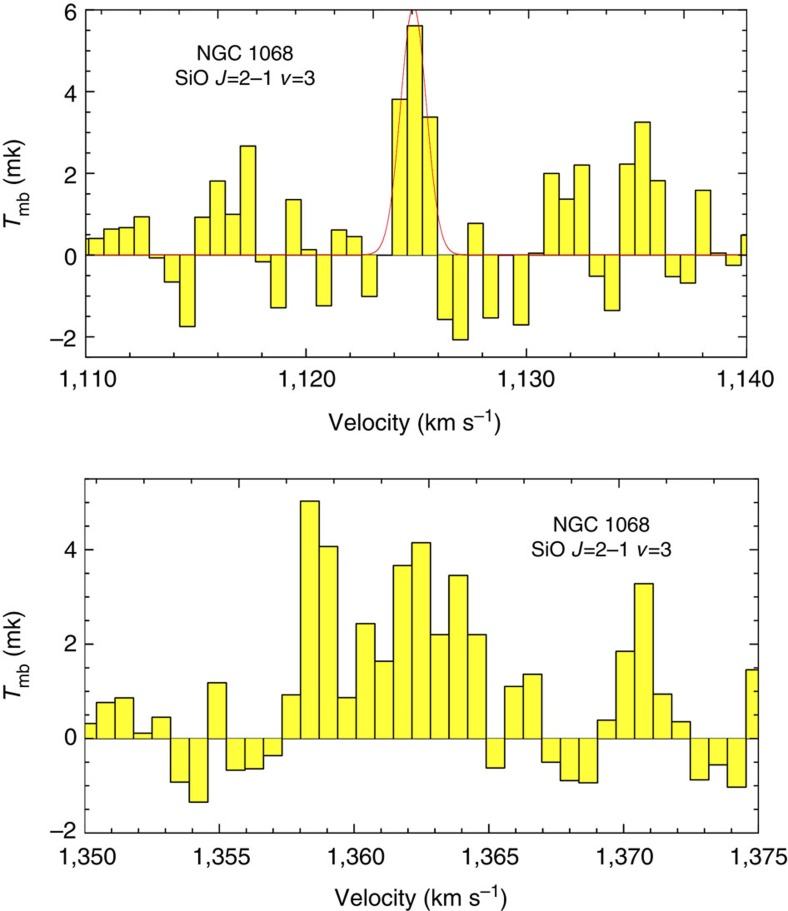
SiO maser emissions detected in NGC 1068.Top: SiO J=2−1 (υ=3) maser emission at the velocity of 1,125 km s−1 in NGC 1068 detected with IRAM 30-m telescope, the noise level is about 0.93 mK at this velocity resolution (~0.69 km s−1), The x axis is the radio-defined velocity of SiO J=2−1 (υ=3), while the y axis is the main beam brightness temperature. The red line is the Gaussian fitting. Bottom: the same as that in the top but at the velocity of 1,362 km s−1.